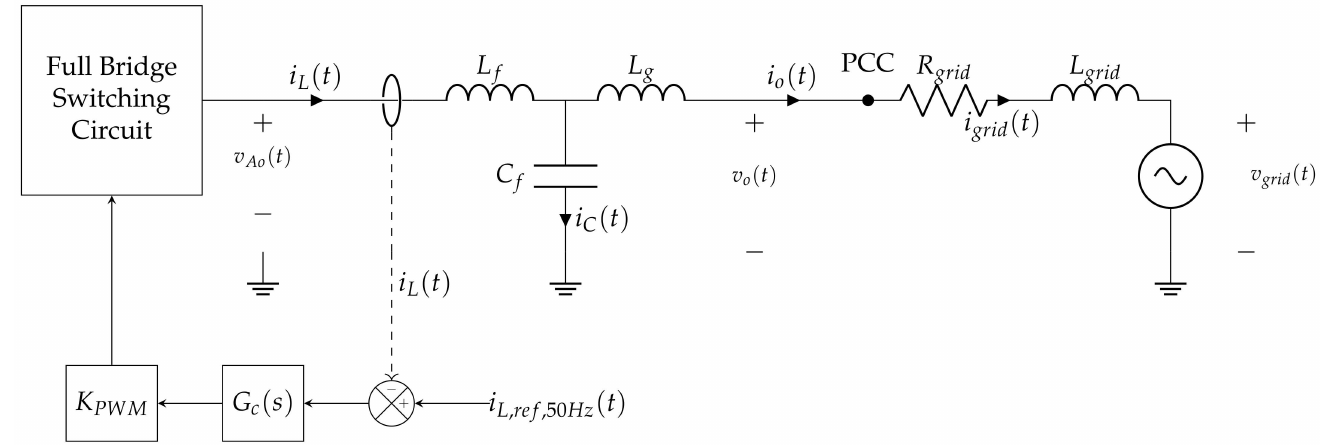
Figure 1. Circuit diagram of the grid-tied inverter under investigation.